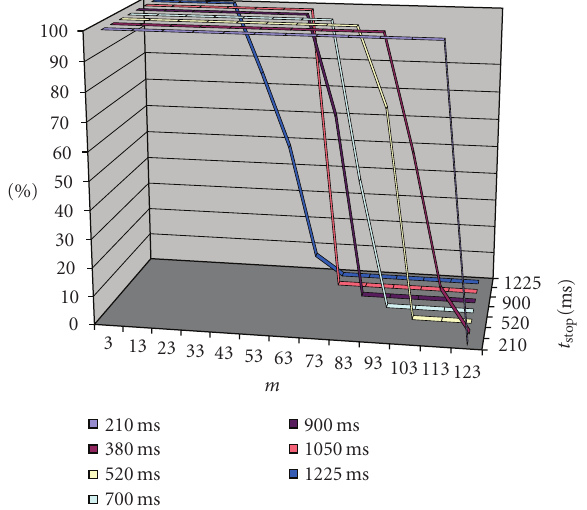
Figure 14: Successful recognition percentage as function of t settle and time window ( m ) for speed of movement 7,48